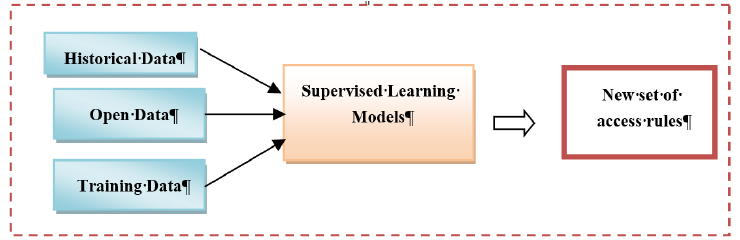
Fig. 2. Inputs and Outputs of Supervised Learning